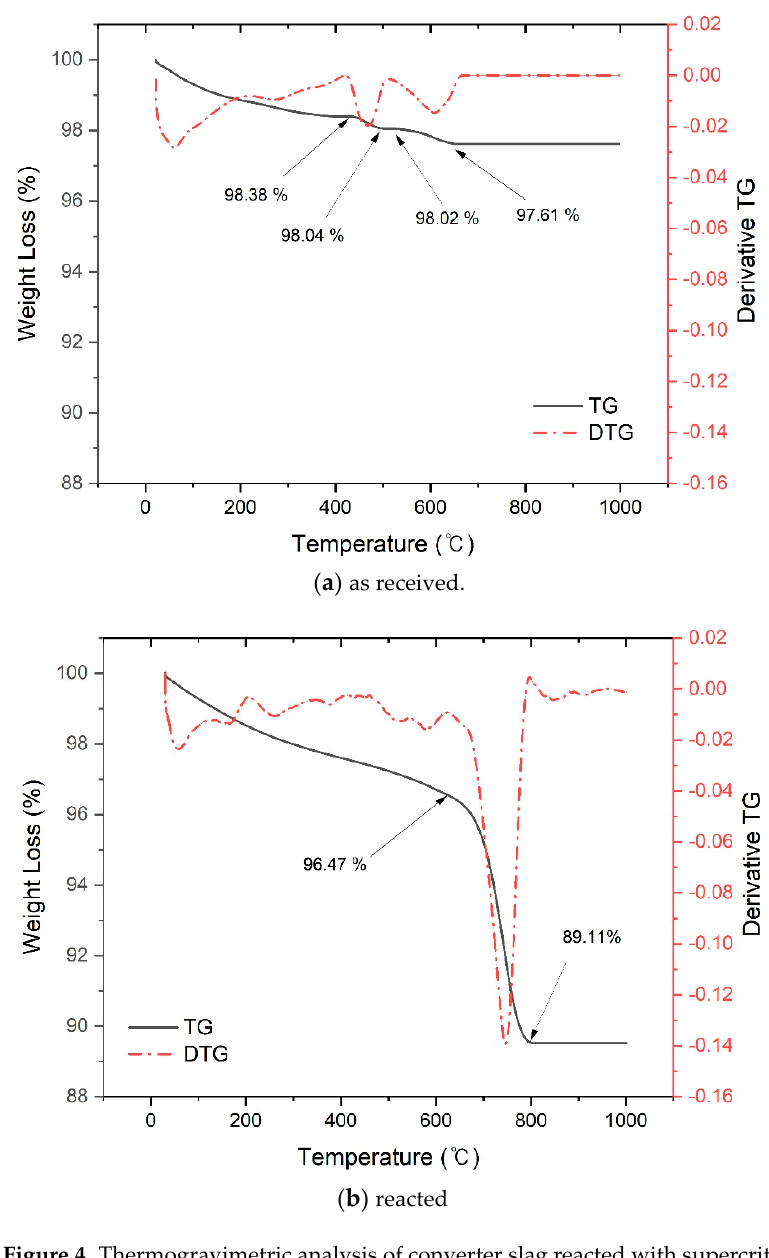
Figure 4. Thermogravimetric analysis of converter slag reacted with supercritical carbon dioxide .